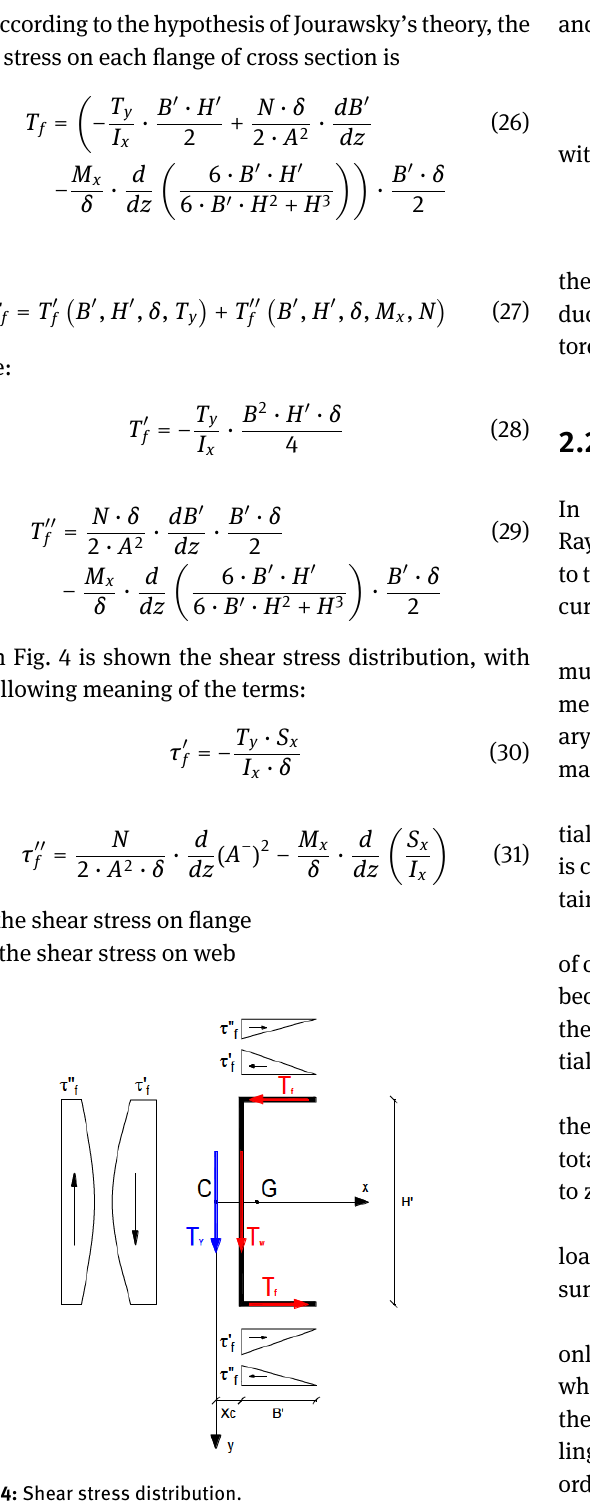
Figure 4: Shear stress